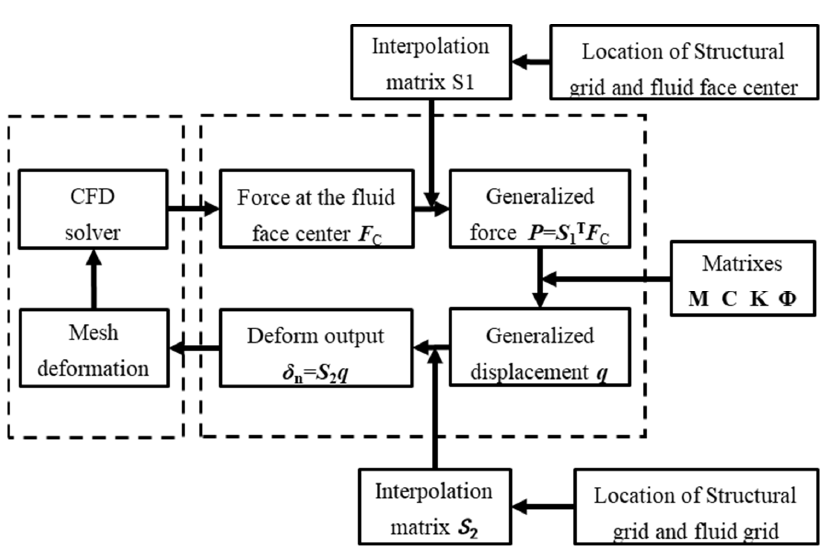
Figure 2. Flowchart of CFD–CSD coupling.